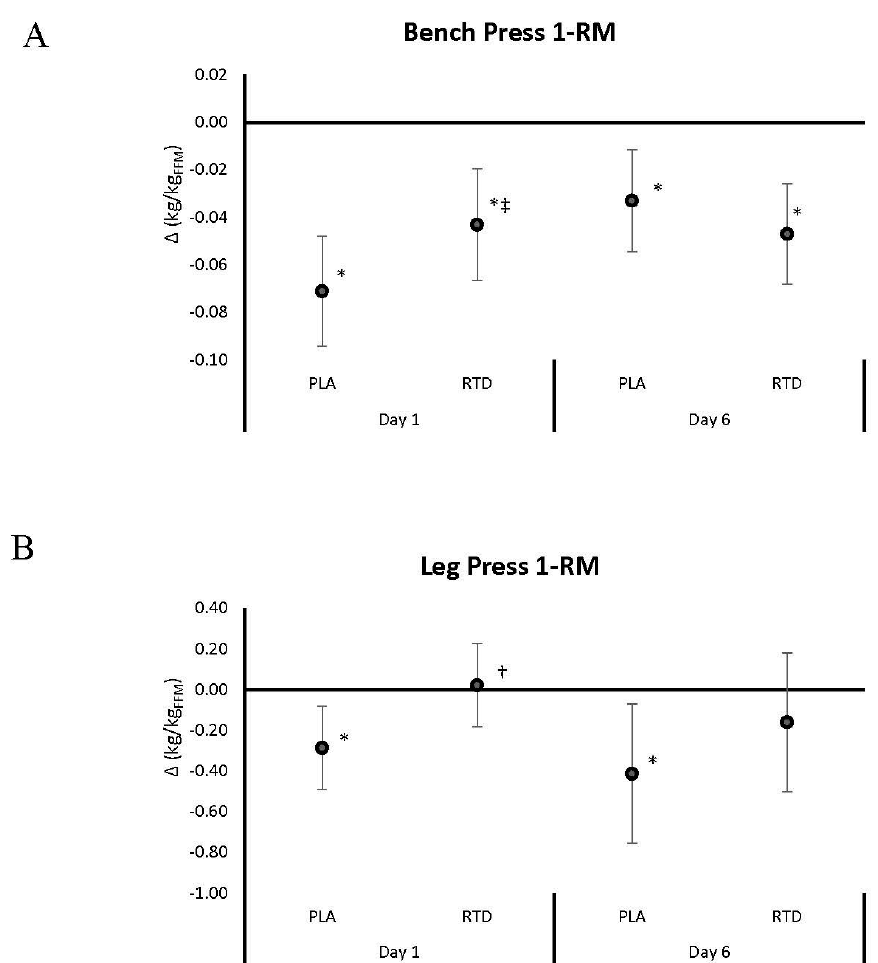
Figure 2. Data present mean change (95% CI) in bench press (Panel A ) and leg press (Panel B ) one repetition maximum (1-RM) from baseline. Confidence intervals not crossing zero are statistically significant ( p < 0.05). * Represents p < 0.05 difference from baseline, † represents p < 0.05 difference between treatments. ‡ Represents p < 0.05 to 0.10 tendency towards significance between treatments.